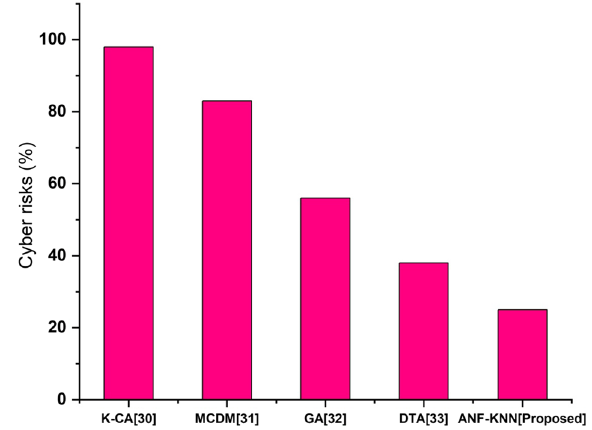
Fig. 12 Cyber-risk comparison of existing and proposed